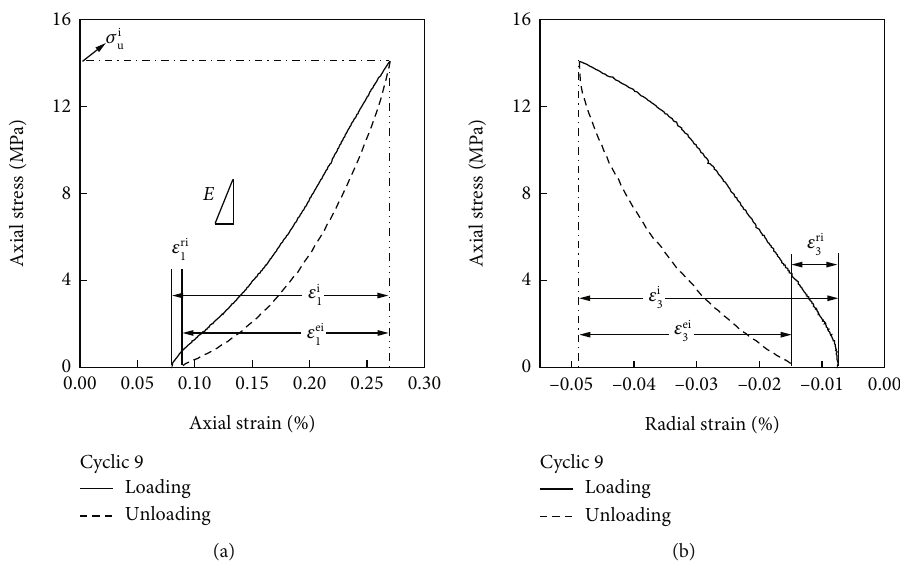
Figure 3: Calculation method of deformation parameters of sandstone under cyclic loading: (a) axial strain; (b) radial strain.